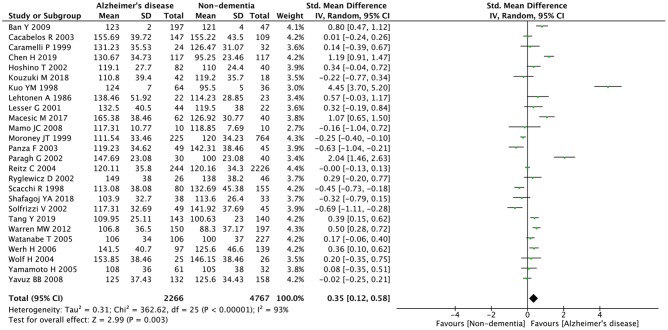
Forest plots of the comparisons in relation to LDL-c levels between Alzheimer's disease and non-dementia. CI, confidence interval.